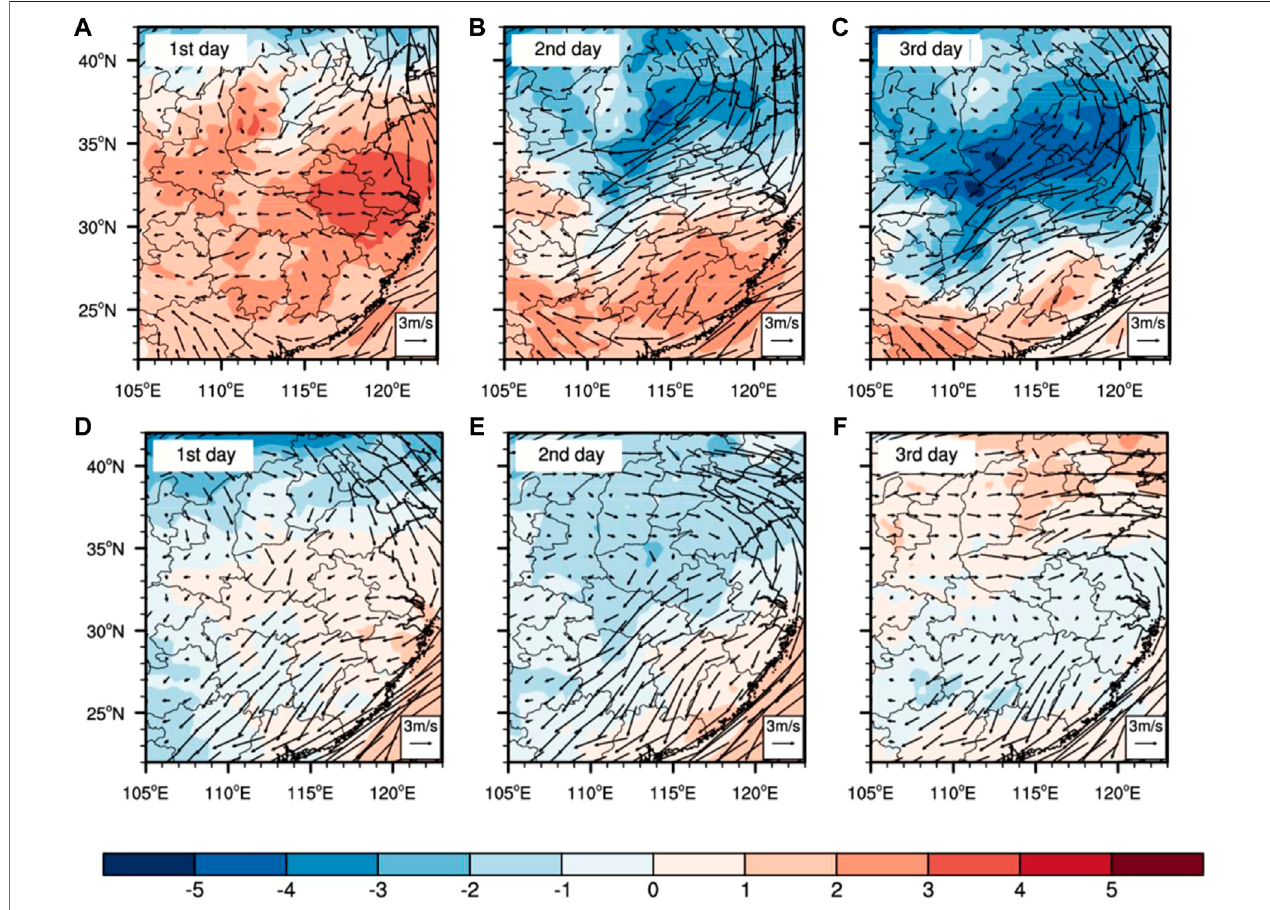
FIGURE 6 | Spatial distributions of 925 hPa air temperature anomalies (color contours; K) and mean wind vectors(arrow) during the heavy air pollution process averaged over six severe PM 2.5 episodes of the top row (A,B,C) RTT and bottom row (D,E,F) SAT.